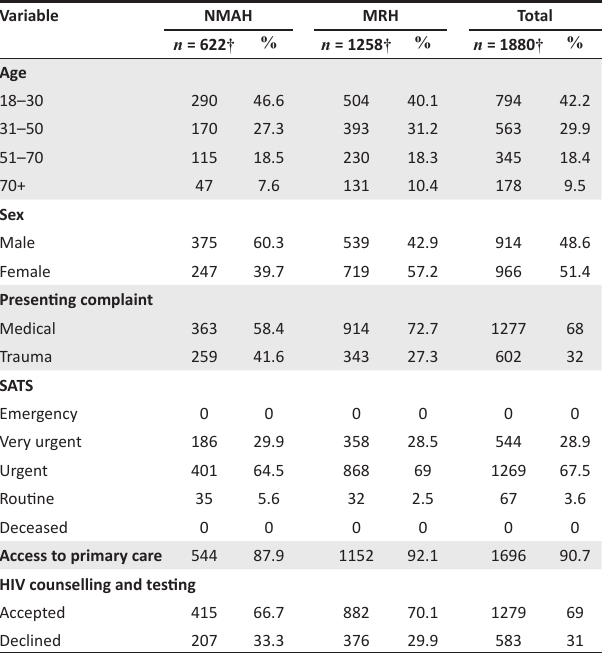
TABLE 1: Characteristics of emergency department patients at Nelson Mandela Academic Hospital and Mthatha Regional Hospital.